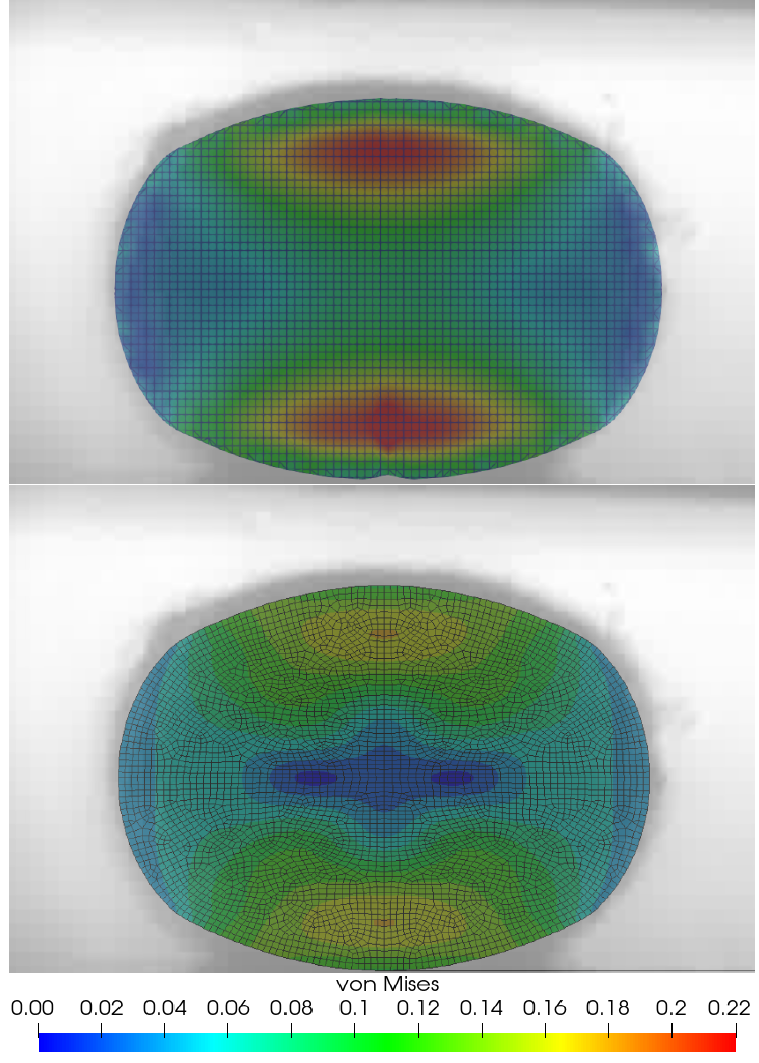
Figure 3. Experimental spheroid shape at t = 132 (background), viscoelastic fluid ( top ) and viscoelas- tic solid ( bottom ) elastic energy distribution in terms of von Mises deviatoric